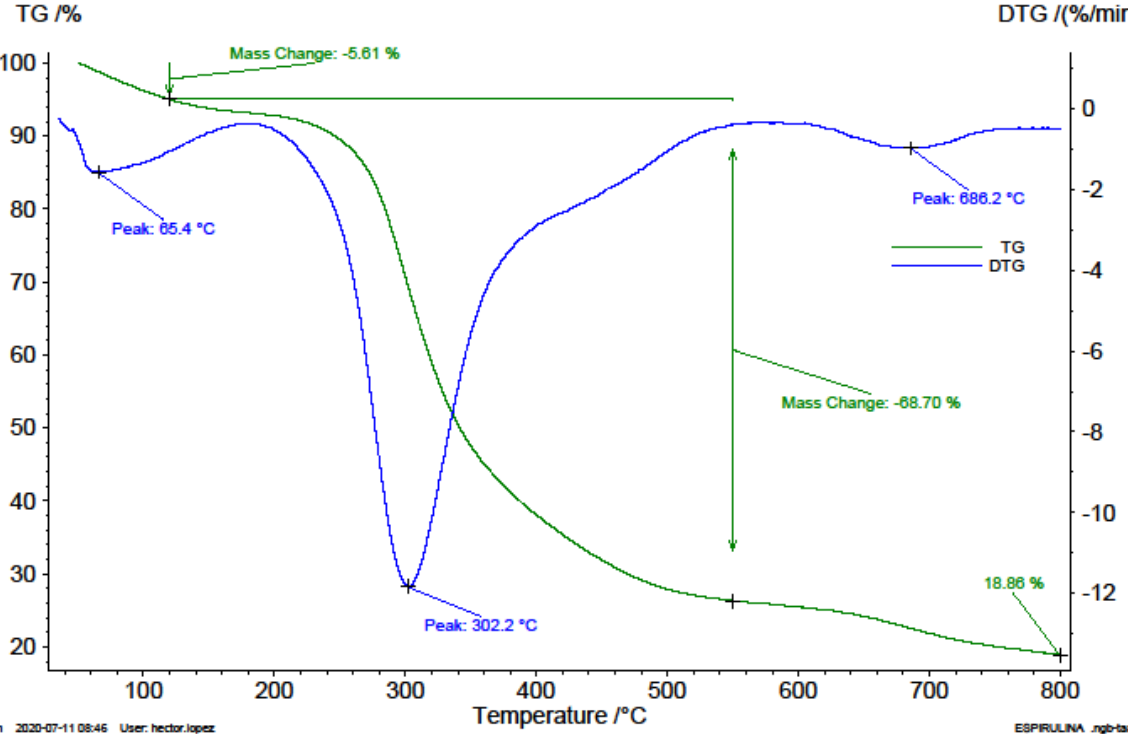
Figure 2. TG an DTG thermograms of photobioreactor microalgae consortium sample (A2).